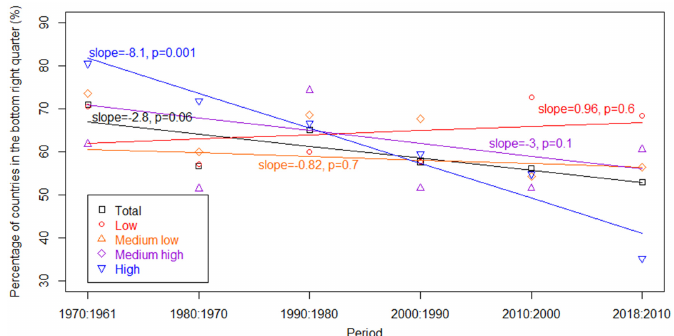
Figure 8. Each period’s percentage of countries located in the bottom right quarter, respectively, for all, low, medium-low, medium-high, and high countries. Solid lines are best-fit lines of least squares linear regression models.